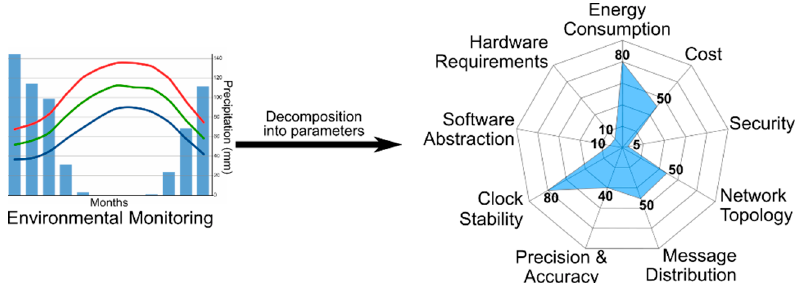
Figure 6. Radar chart generated for the specific requirements of an environmental monitoring application. Low values represent few constraints or big freedom in the selection, and large values represent high demands or very restrictive conditions.